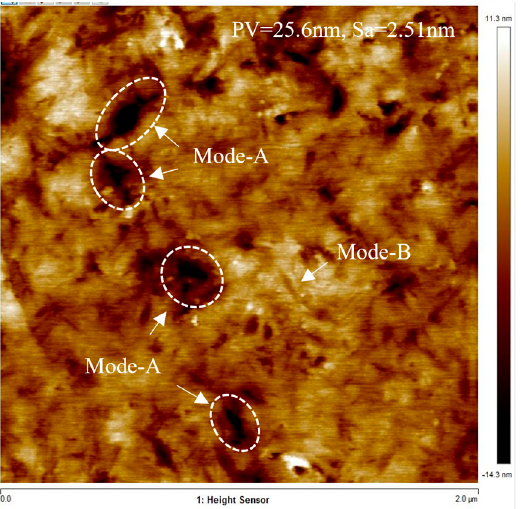
Figure 16. AFM images of the finished surfaces (time = 300 s, gap = 0.15 mm, amplitude = 30 μ